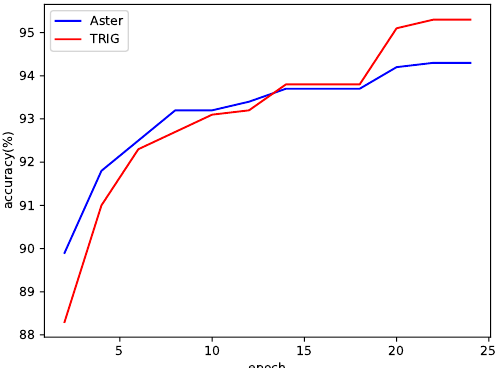
Figure 4. The accuracy on IIIT between TRIG (Ours) and ASTER during the training